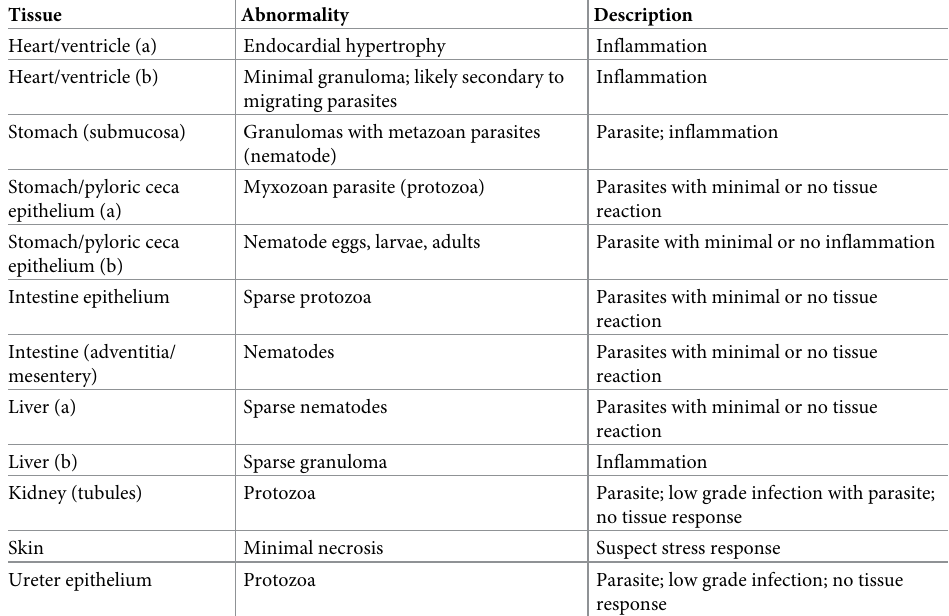
Table 1. Histological findings in shortspine thornyhead tissues.